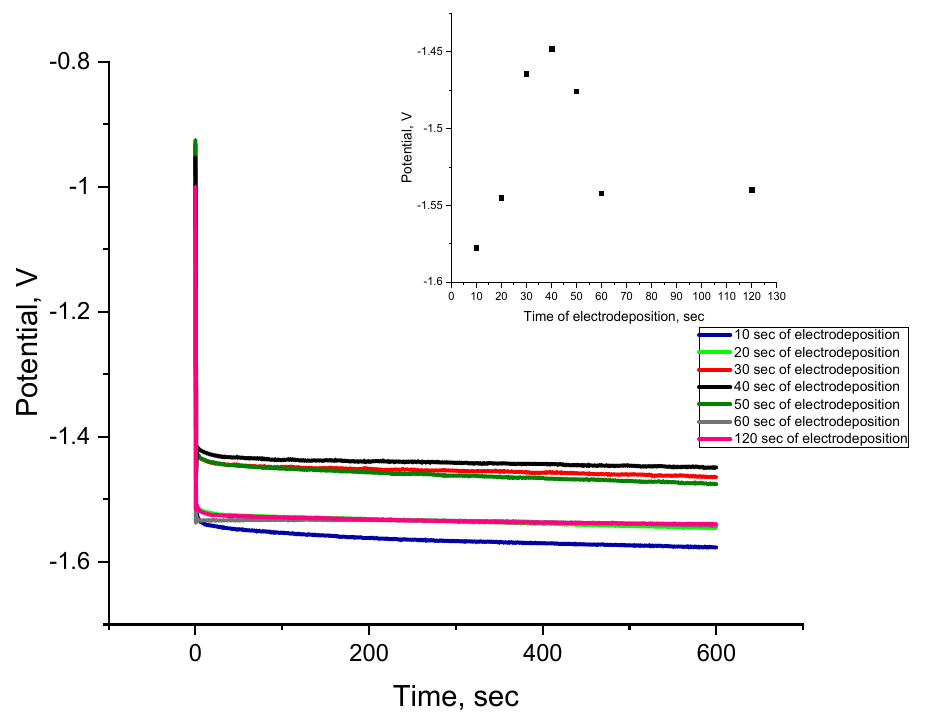
Figure 9. Results of chronopotentiometry measurements for samples electrodeposited for various time.